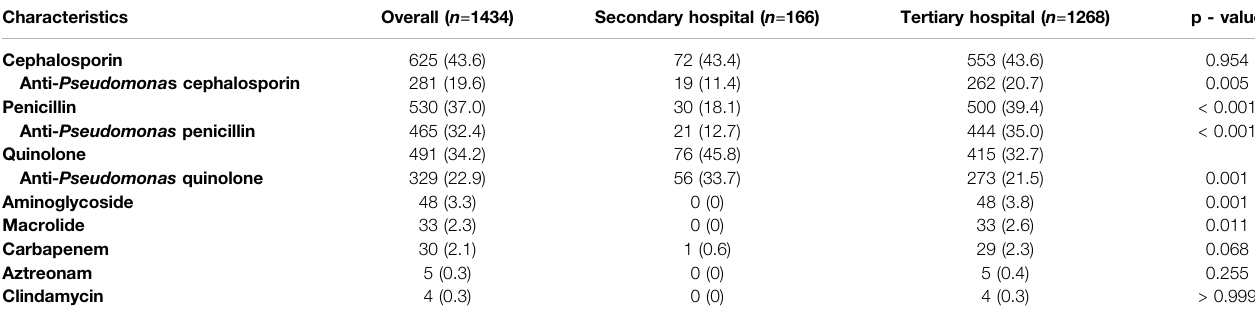
TABLE 3 | Antibiotic prescriptions of included AECOPD patients receiving antibiotic treatment. Characteristics